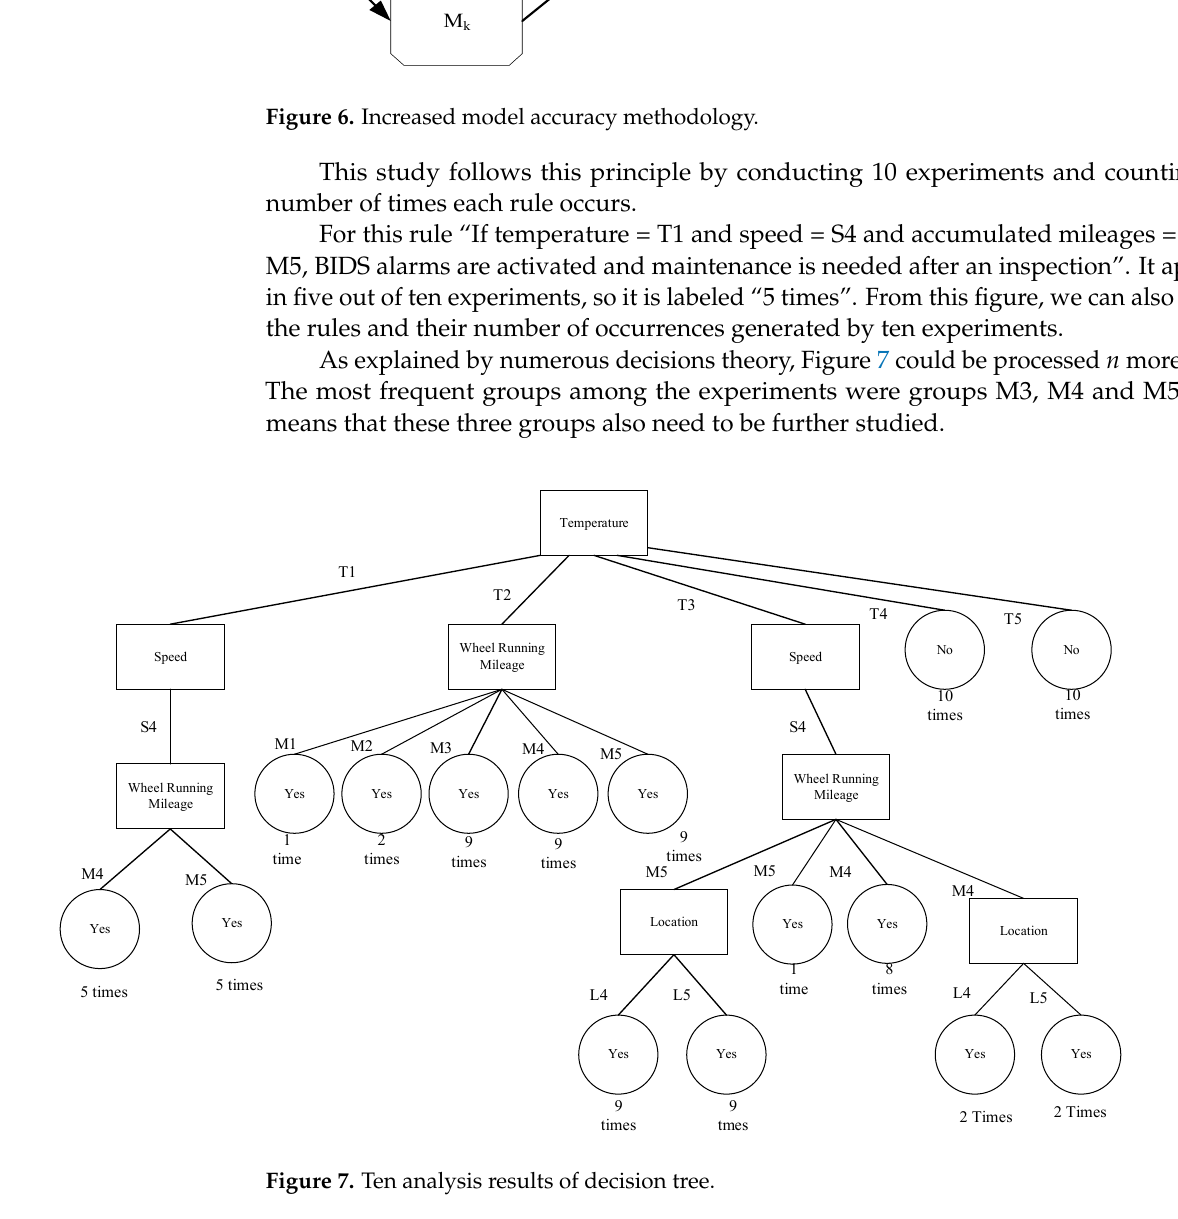
Figure 8. Trainset accumulated mileage factor. With respect to train sets belonging to T1, train sets with accumulated mileages of M4 and M5 each occur five times, but rules of M4 already contain rules of M5; therefore, all can be expressed by M4. With the same concept, accumulated mileage rules of train sets belonging to T1 can all be expressed by M3. The decision tree is thus pruned as illus- trated in Figure 9.